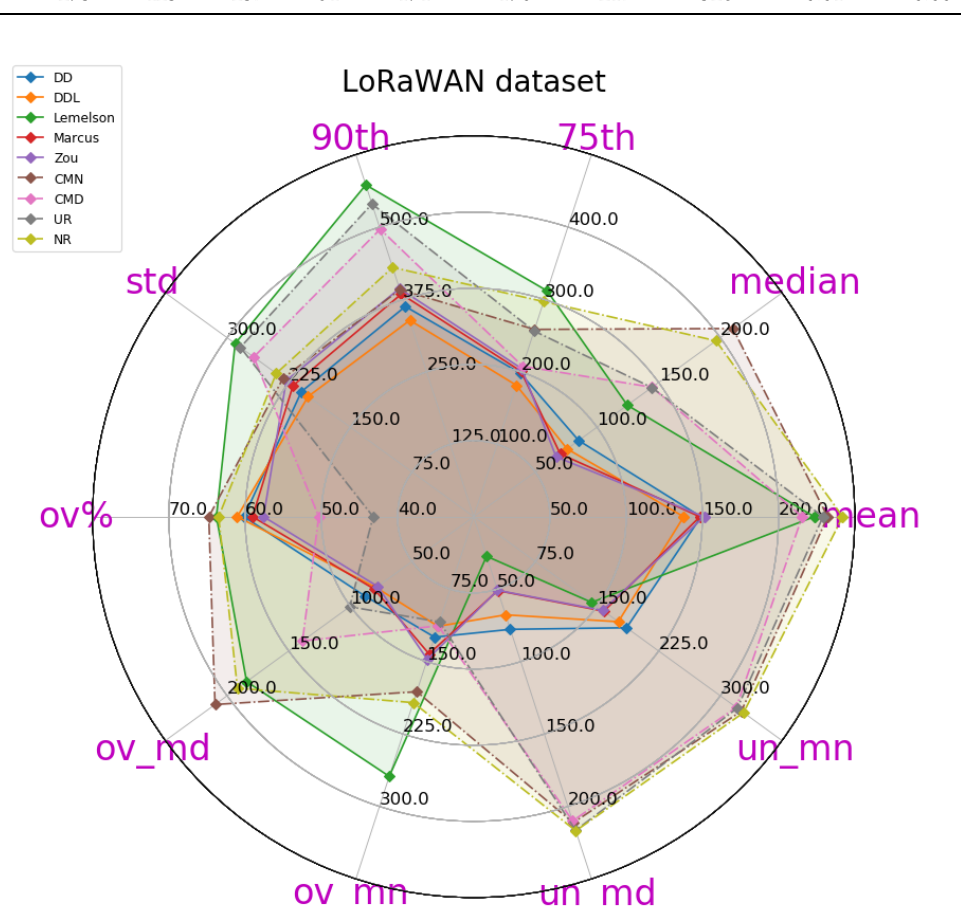
Figure 8. A radar plot of most of the relevant metrics for the DAE evaluation of various methods, on the validation set of the LoRaWAN dataset. Methods are depicted in continuous lines while baselines are in dashed lines. This plot depicts metrics and values of all methods, as reported in Table